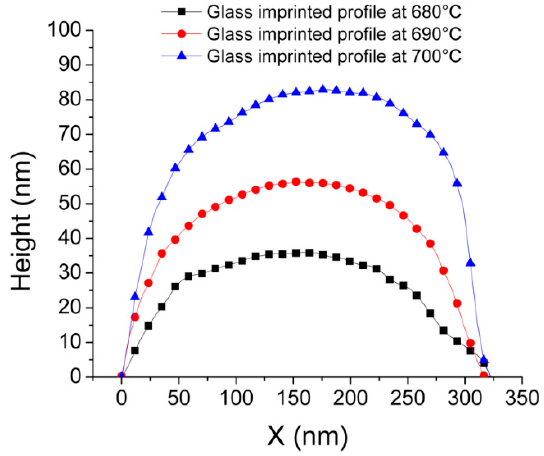
Figure 5. Comparison of cross-sectional surface profiles of glass imprinted cross-sinusoidal nanostructures at different imprinting